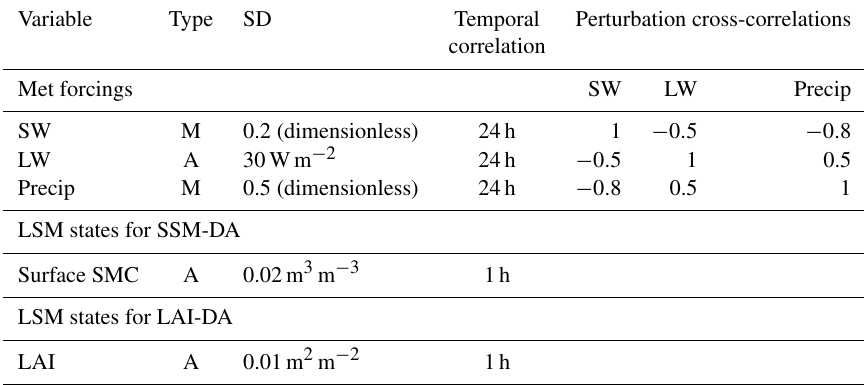
Table 1. Ensemble perturbation parameters in the assimilation simulations. Variable Type SD Temporal Perturbation cross-correlations correlation Met forcings SW LW